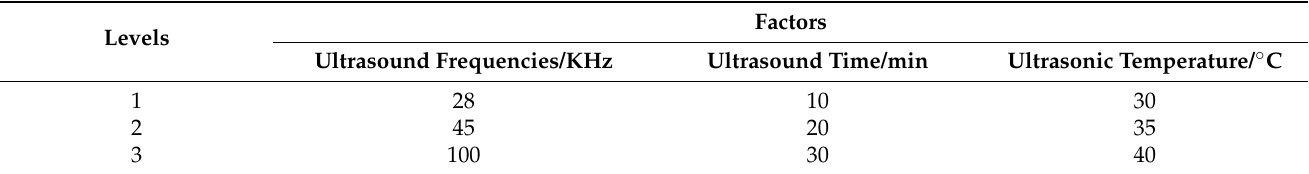
Table 1. Factors and levels of the orthogonal